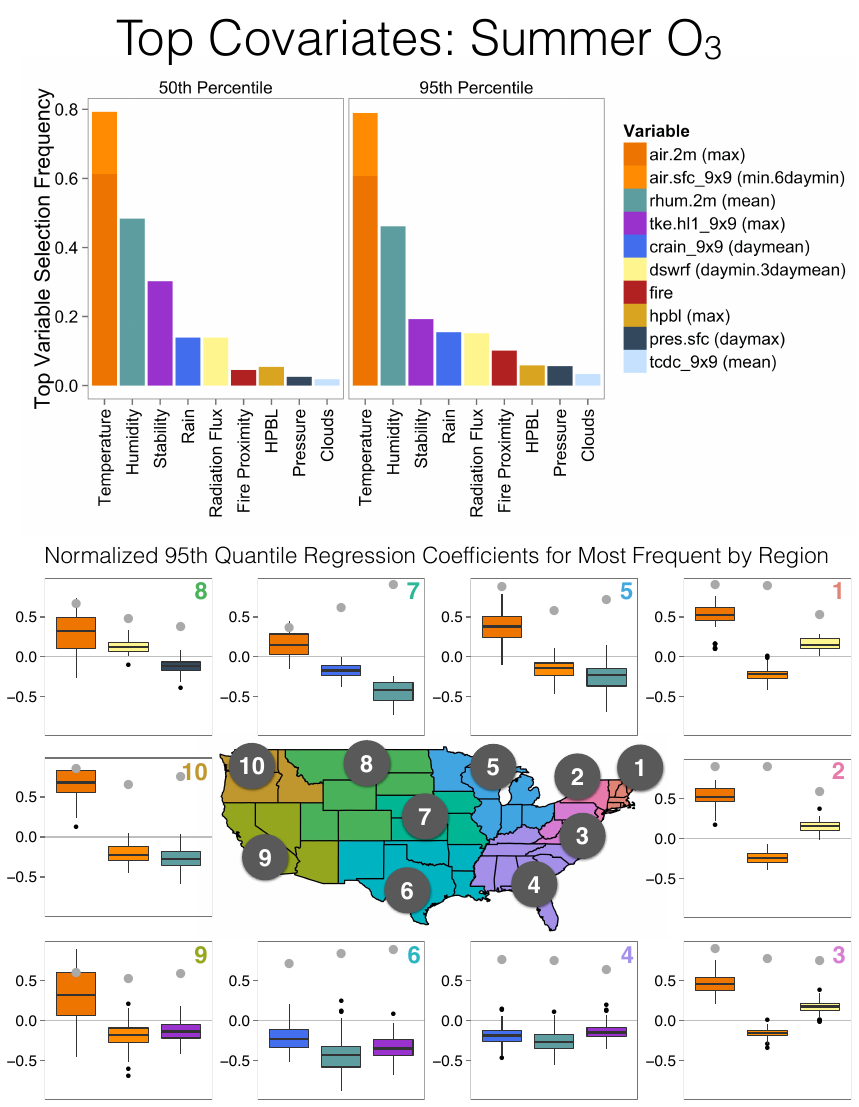
Figure 4. Frequency at which normalized 95th percentile QR coefficients for selected variables were in the top two out of all included variables (above) for summer O 3 , and box plots of normalized regression coefficients for top three covariates in each region (below). Specific meteorological variables (shown in legend) have been grouped into categories shown on the x axis of the bar plot. Colors on inset box plots correspond to legend in above panel, and gray dots indicate the fraction of stations showing a statistically significant relationship ( p ≤ 0.05) to the indicated covariate in that region. EPA Region numbers are inset on top-right of box plot